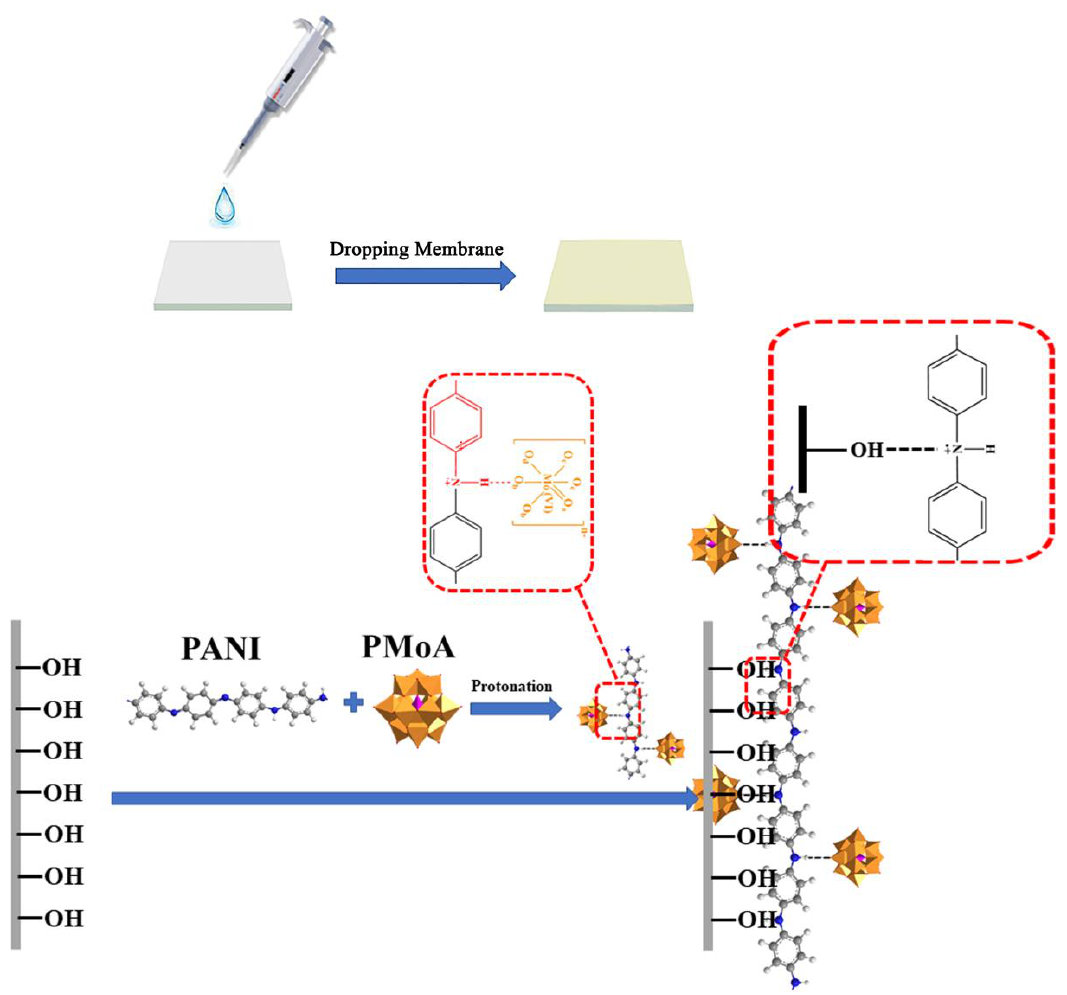
Figure 1. The protonation process to fabricate a PMoA/PANI hybridizing thin film.